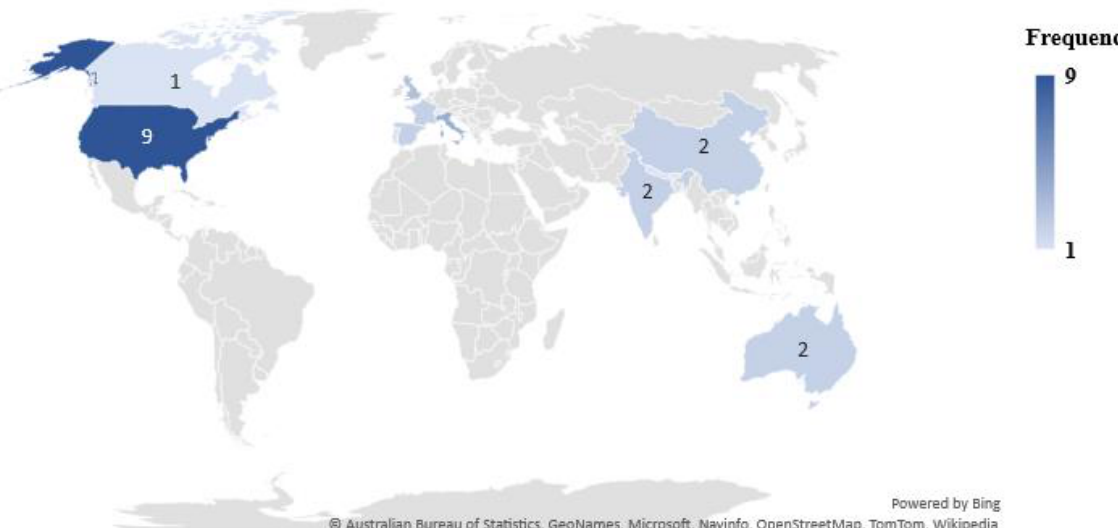
Figure 4. Geographic distribution of the reviewed studies in UIAQS technologies.